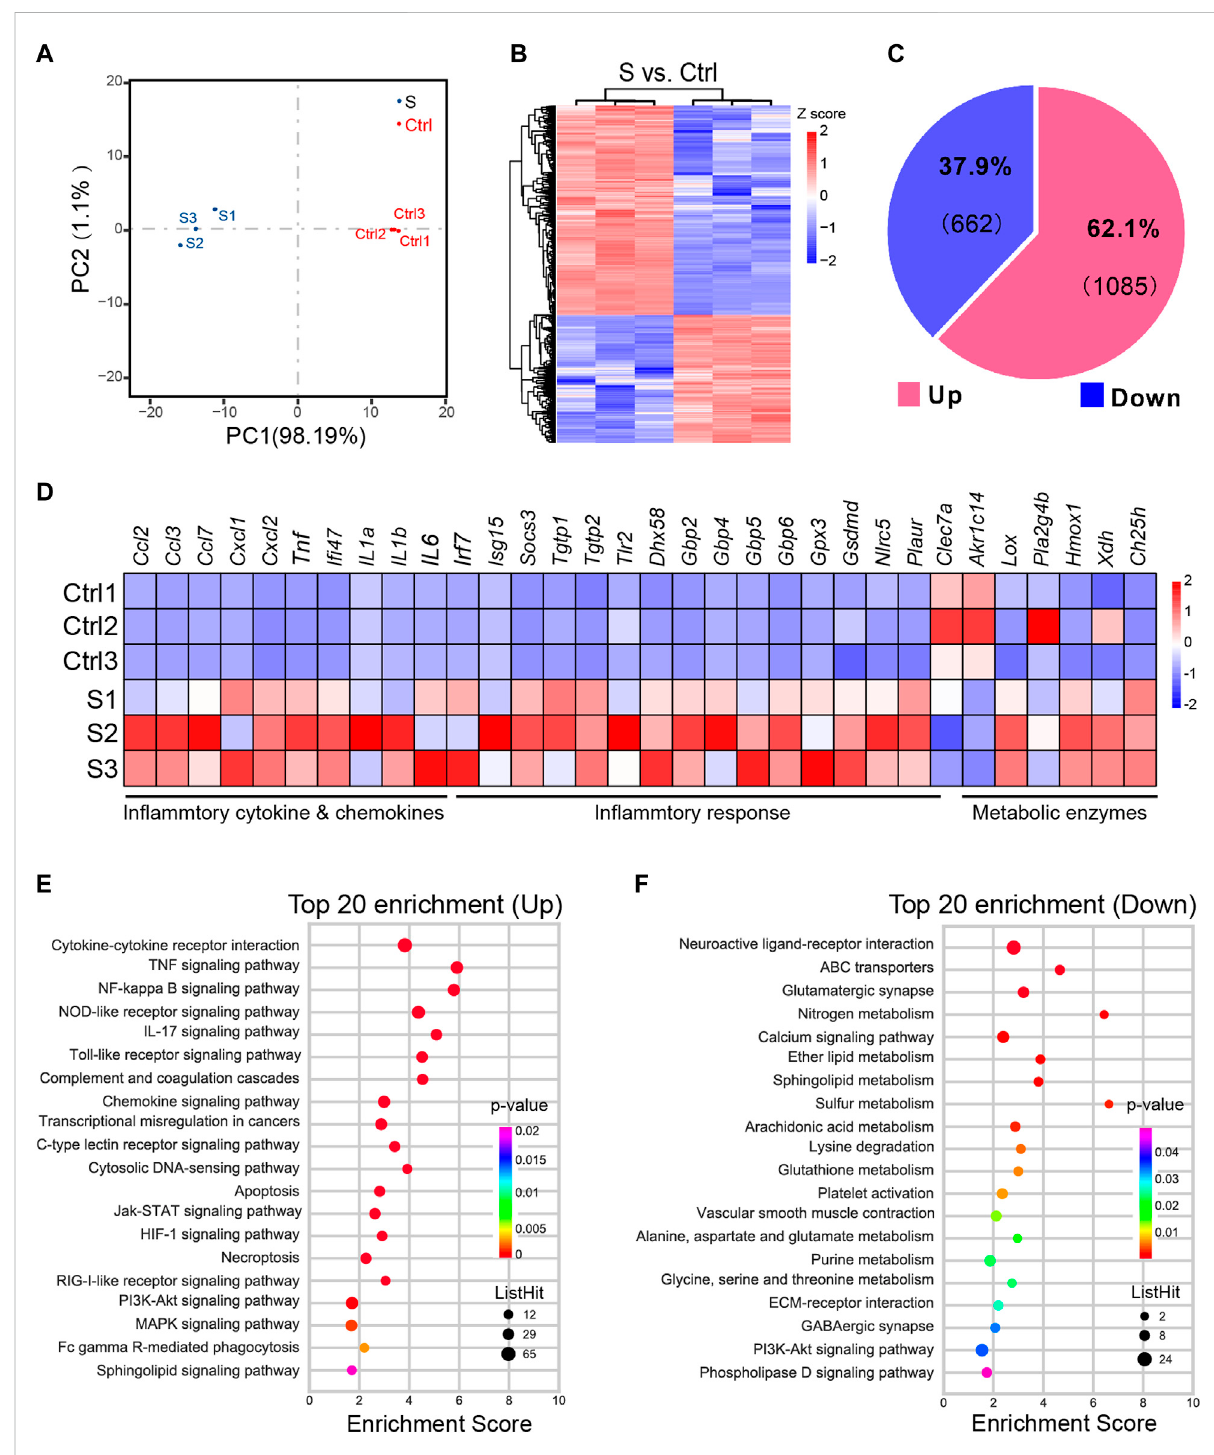
FIGURE 4 Differentially expressed genes pro fi ling of the hippocampus in the SAE (S) and control groups (Ctrl). (A) The PCA analysis of hippocampus from SAE-andCtrl-groupedmice( n =3). (B) Theheatmapofdifferentiallyexpressedgenes(DEGs)withacutofflog2FCof > 1andpof < 0.05( n =3). (C) The pie chart illustrating the composition of up- and downregulated DEGs. (D) Heatmap of RT-qPCR analysis showing upregulation of in fl ammatory cytokines and chemokines, in fl ammatory response, and metabolic enzymes gene expression in the hippocampal tissues, i.p., injected with LPS ( n = 3). (E,F) The top 20 KEGG enrichment of upregulated (E) or downregulated DEGs (F)